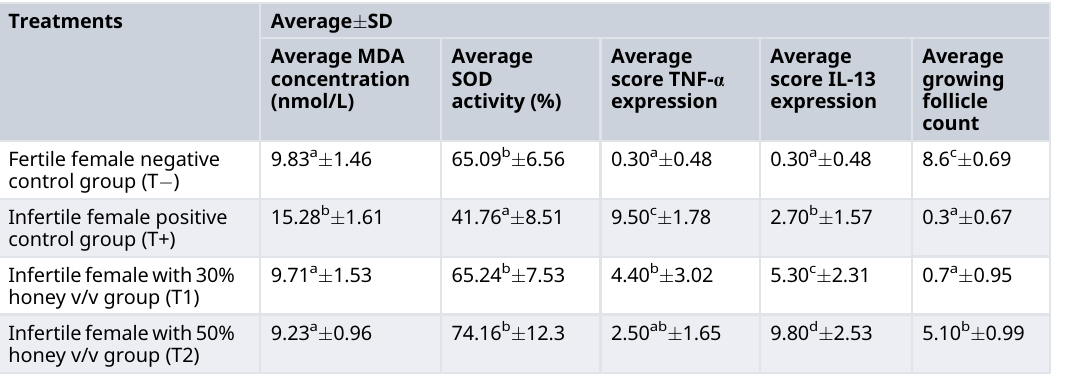
Table 2. The average of MDA concentration, SOD activity, TNF- α and IL-13 score expression, and growing follicle count in the ovarian rat tissue. Treatments